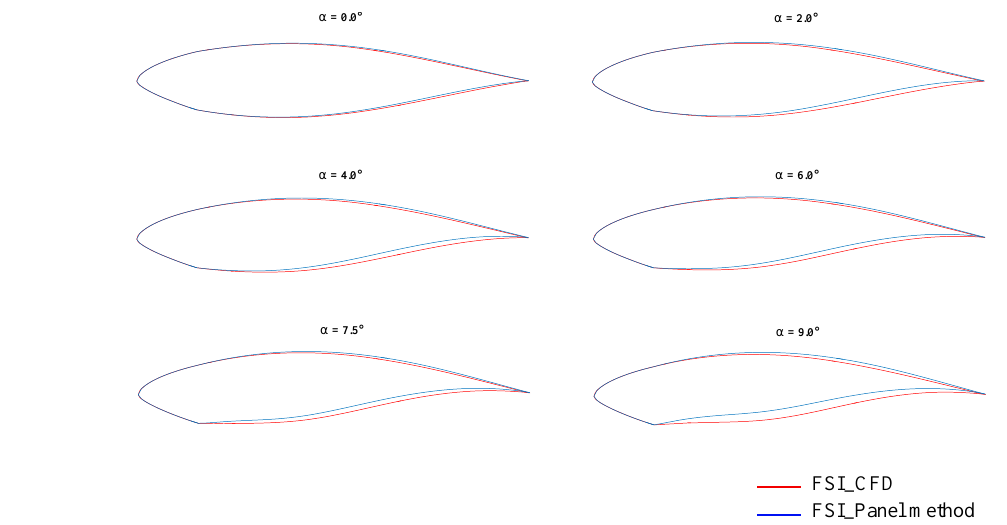
Figure 17. Comparison of the converged cross section in the mid-span section of the second segment from the root.